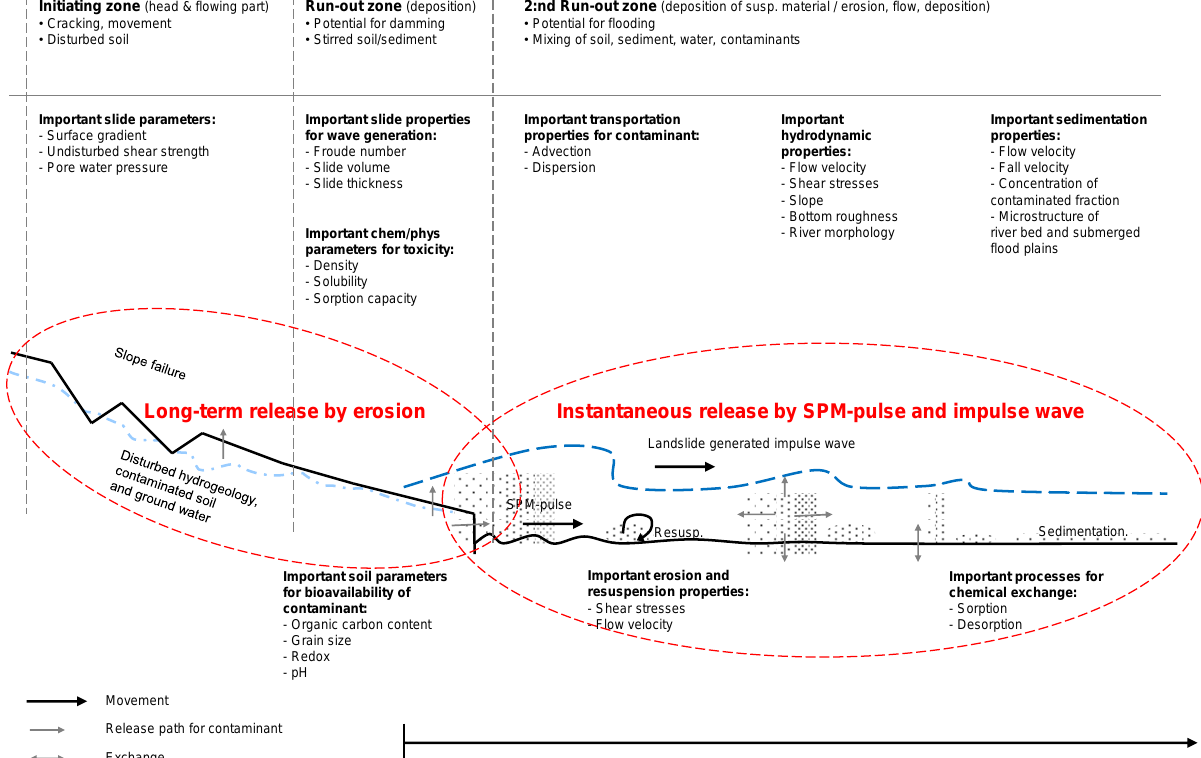
Fig. 1. Schematic description of the release of contaminants into surface water from a landslide (further developed from G¨oransson et al., 2009). In landslide nomenclature, the zone where a mass movement is initiated is referred to as the “initiating zone”, and the zone where deposition takes place is in general referred to as the “run-out zone”. The illustration describes how the event can be divided into three zones, depending on processes, and what the governing process parameters are in each zone. After the event, the release and transport of contaminants can be divided into an instantaneous release and a long-term release (dashed